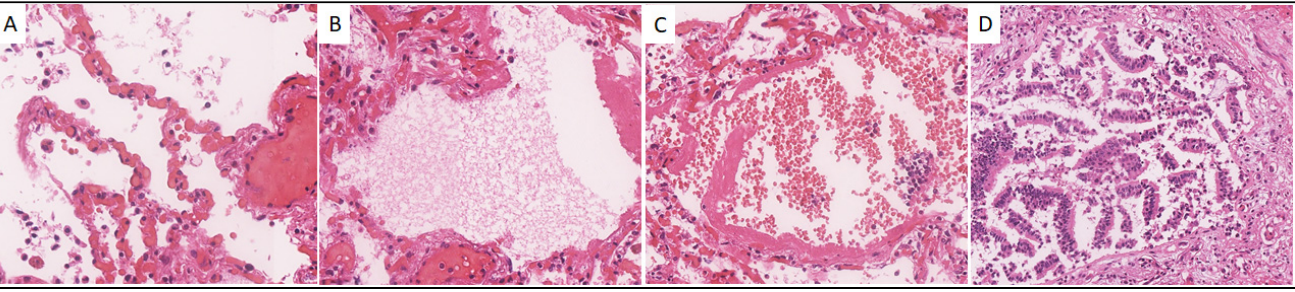
Figure 3. Histological picture of the lungs of patient No. 10. ( A ). Congestion and stasis of the capillaries of the interalveolar septa, intraalveolar cell detritus, ×300; ( B ) . Intraalveolar edema and hyaline membranes, ×300; ( C ) Hyaline membranes and intraalveolar extravasates, ×200; ( D ) Desquamation of bronchiolar epithelium, ×200. Hematoxylin ‐ eosin staining.